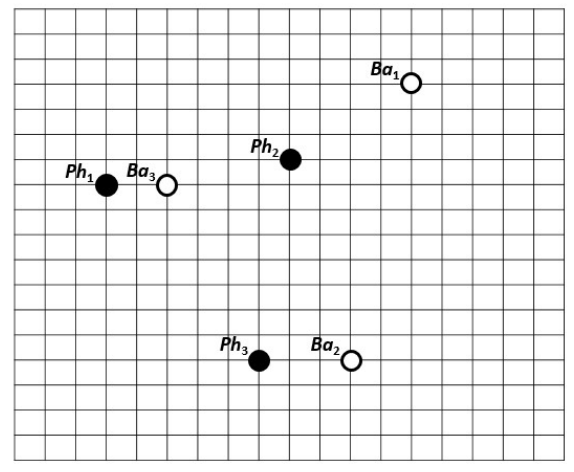
Figure 1: An example of the initial configuration of the Go game implemented on the Physarum ma- chine